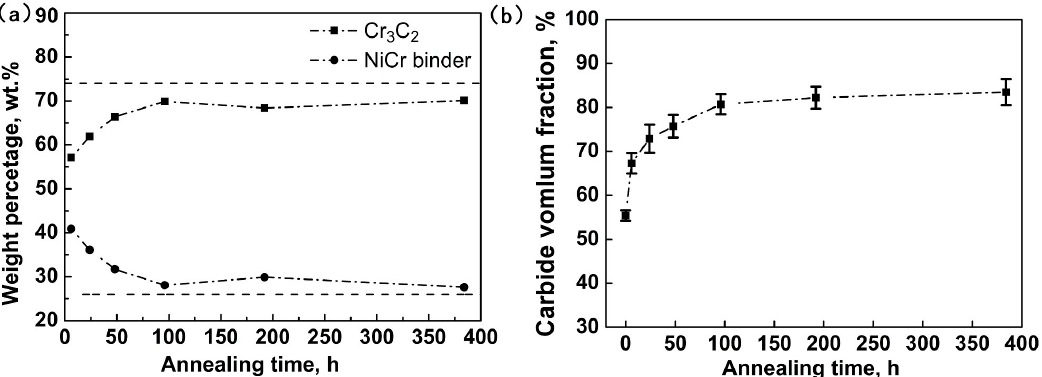
Figure 13. ( a ) Weight fraction of the Cr 3 C 2 and the NiCr binder phase as a function of annealing time obtained from Rietveld refinements; ( b ) variation of the volume fraction of Cr 3 C 2 with annealing time calculated from image analysis.